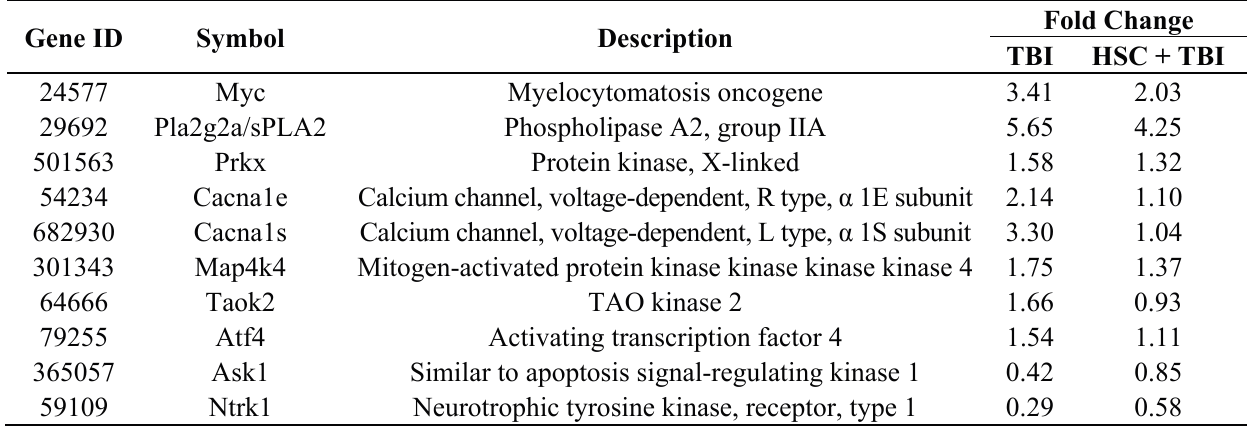
Table 2. The 10 genes that were involved in the MAPK pathways.